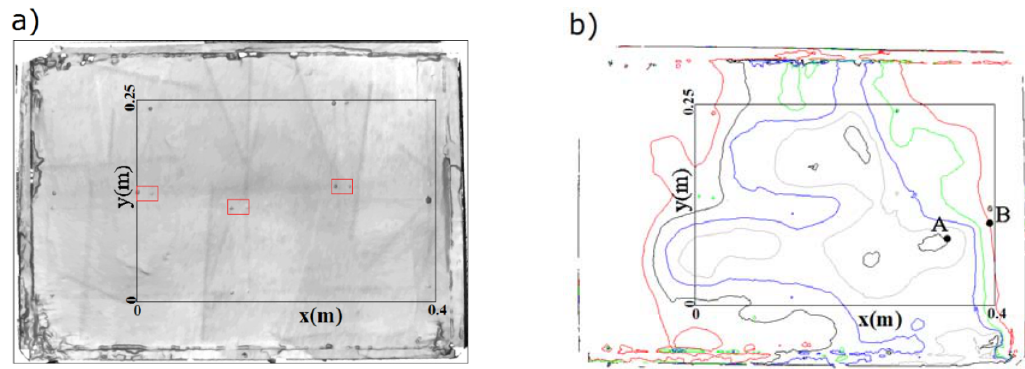
Figure 7. ( a ) Topography grayscale image of the test specimen. The points within the red rectangles show the cuts made to mark the corners of the bricks; ( b ) Contours every 0.25 mm being the lowest in red (0 mm) and the highest in black (1